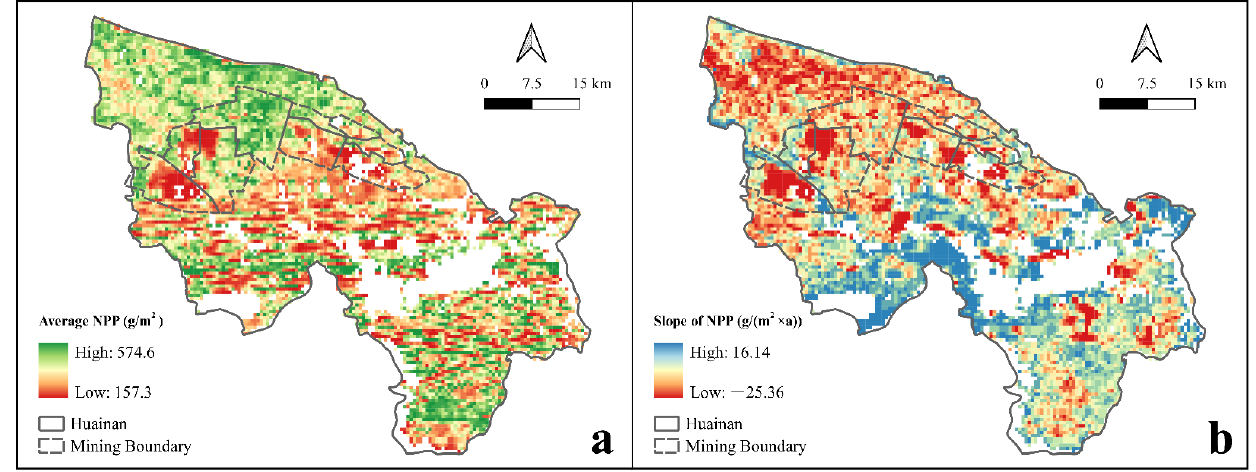
Figure 4. The average value and change trend of NPP from 2001 to 2020: ( a ) average value; ( b ) change trend.